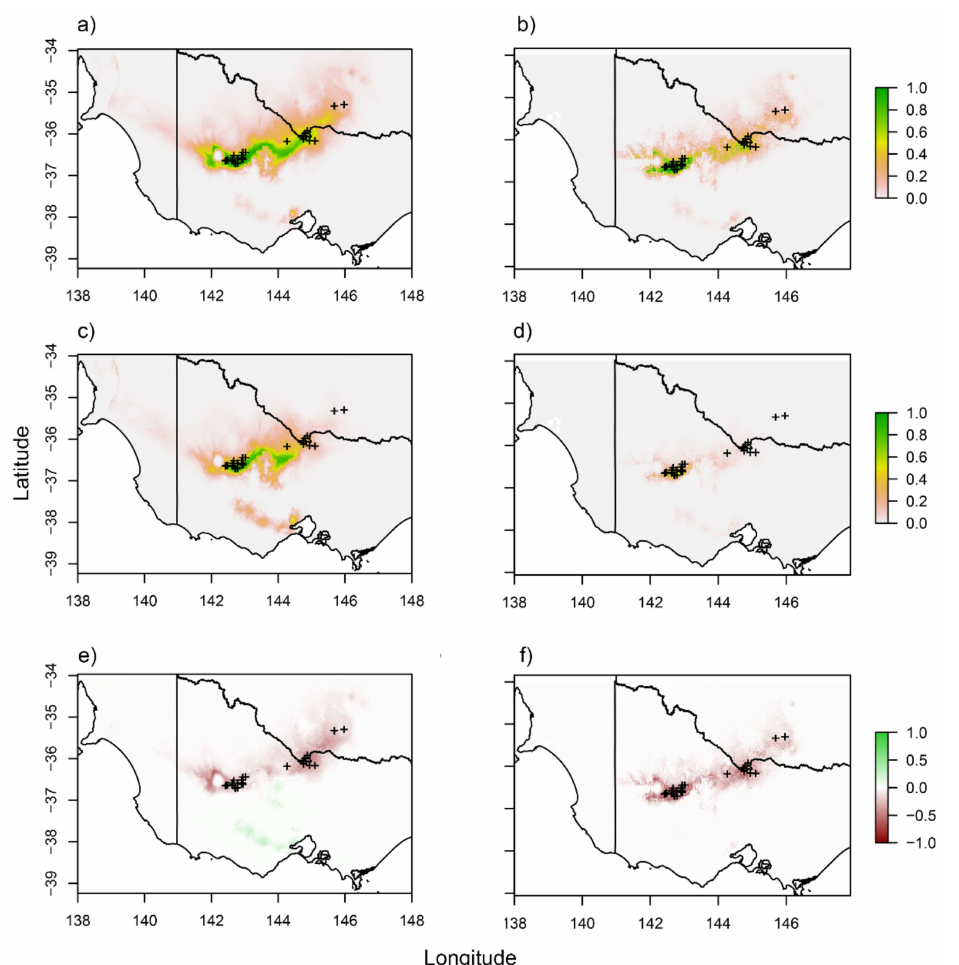
Figure 7. Predicted suitable habitat for Sclerolaena napiformis based on collections performed during this study. Modelling was based on ( a ) current climate, ( b ) current climate and soil composition, ( c ) future climate, ( d ) future climate and current soil composition. We also show a shift in climate suitability ( e ) excluding and ( f ) including current soil variables (increasing suitability shown by green and decreasing shown by red). Modelling was performed using 12 bioclimatic and 8 soil composition variables (Table S1). Future climate predictions are based on a conservative climate scenario (RCP 2.6) projected 50